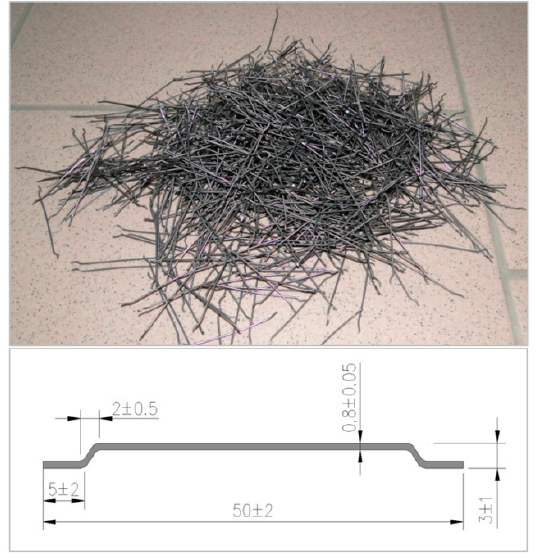
Figure 3. Fibre dimensions and close-up look.